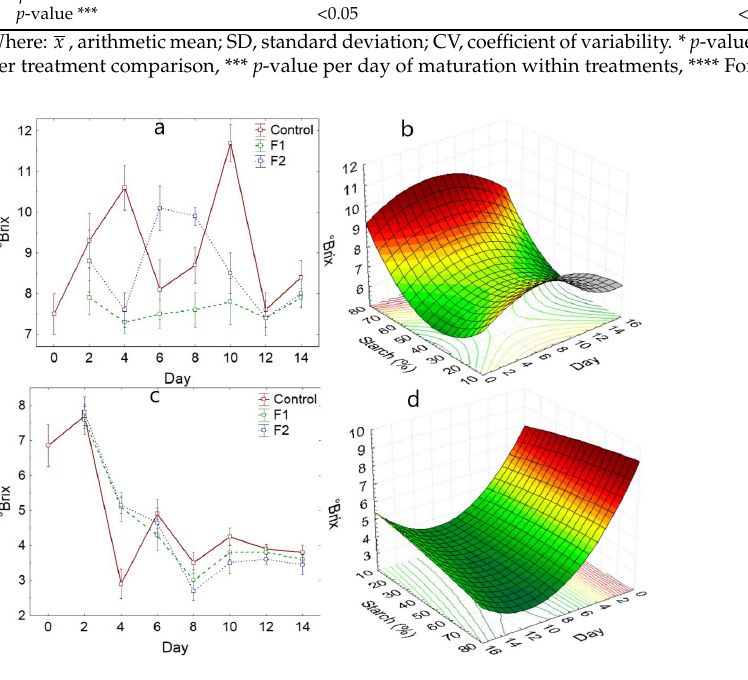
Table 5. Soluble solids (°Brix) of control and coated avocado.